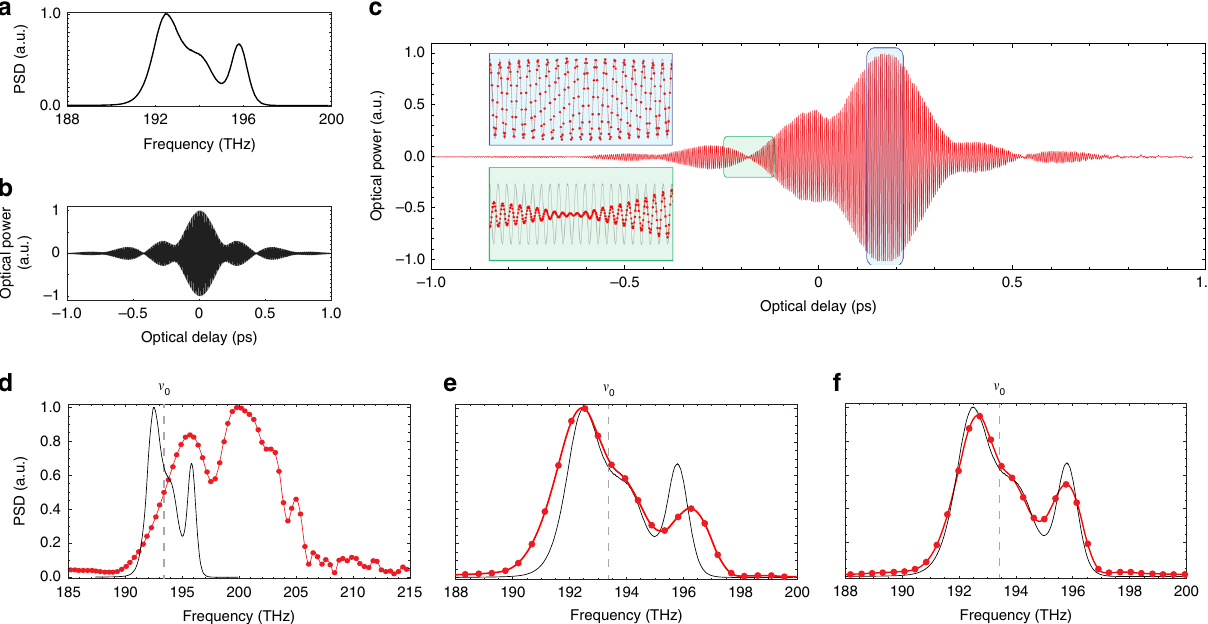
Fig. 3 Broadband spectrum recovery with the Si-FTS. The parameters used to obtain these plots are summarized in Table 1. a ASE of a C-band EDFA used as the light source. b Theoretical interferogram of the ASE for an ideal (linear TOC, dispersionless, balanced) MZI. c Experimental interferogram, shifted to 0.172 ps and distorted due to differences between the two arms of the MZI. The optical delay axis corresponds to T . The insets show a zoom-in of the interferogram at different optical delays superposed to a cosine (gray traces) at the ASE mean frequency ν s = 193.44 THz, highlighting: the oscillations at ν s when the envelope varies slowly (blue-colored zoom-in); phase changes when the envelope varies rapidly (green-colored zoom-in). d – f Experimental (red) and reference (black) PSD at different conditions. The red points are the experimental data obtained from the IFT and the red line is a second-order interpolation curve. d No correction. e Corrected thermo-optic non-linearity, but no dispersion correction nor PSD re-normalization with T ( ν ). f All effects properly accounted